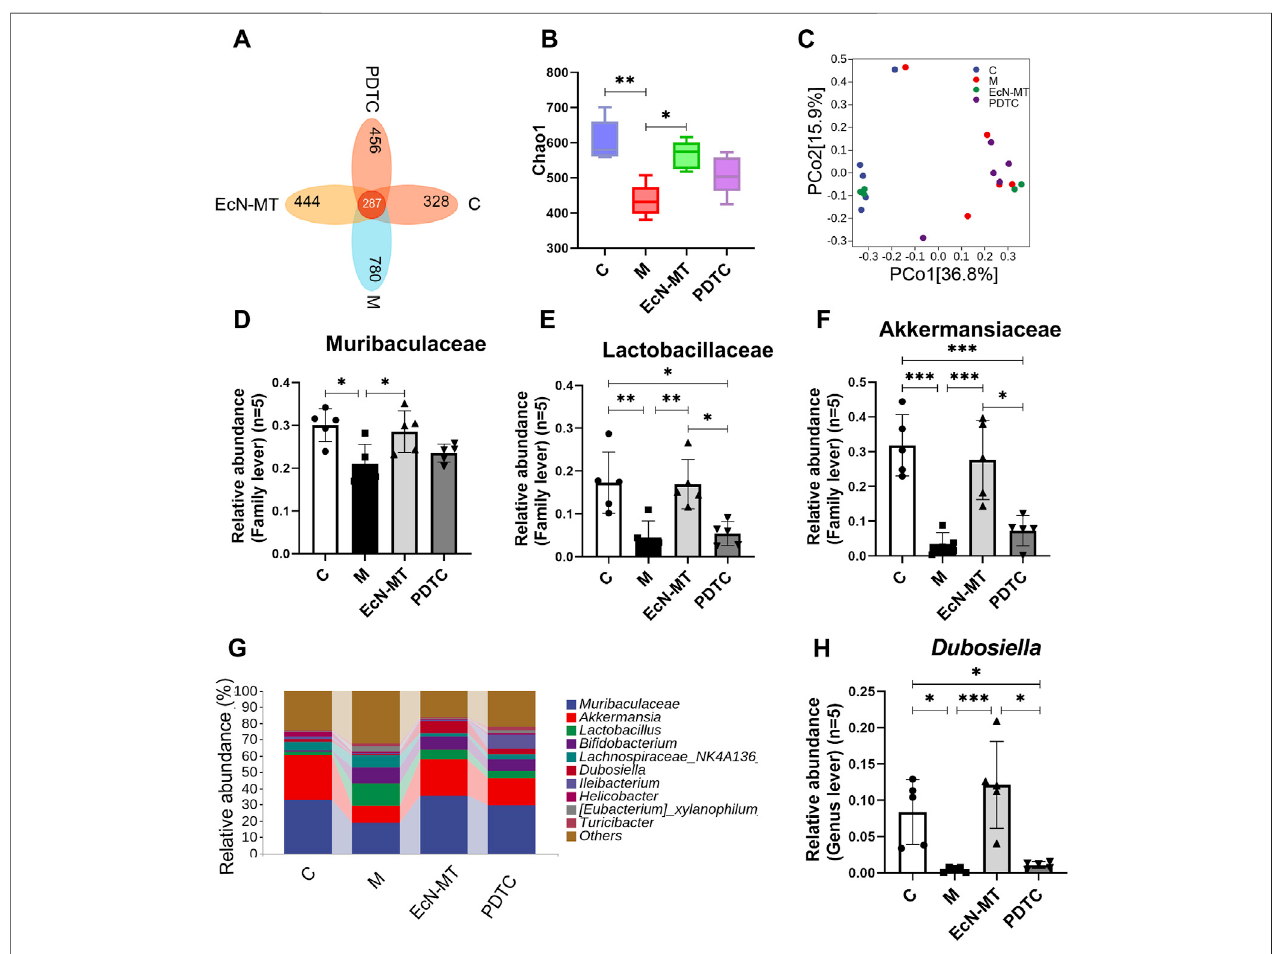
FIGURE 6 | EcN-MT rather than NF- κ B inhibitors improved intestinal microbiota. Values are presented as means ± SD ( n = 5). (A) Venn map representation of OTUs. (B) TheChao1index. (C) PCoAof β diversityindex. (D) Microbiotacompositionatthegenuslevel.Therelativeabundanceof (E) Akkermansia, (F) Muribaculaceae, (G) Lachnospiraceae (H) Dubosiella were analyzed. * p < 0.05, ** p < 0.01, *** p <